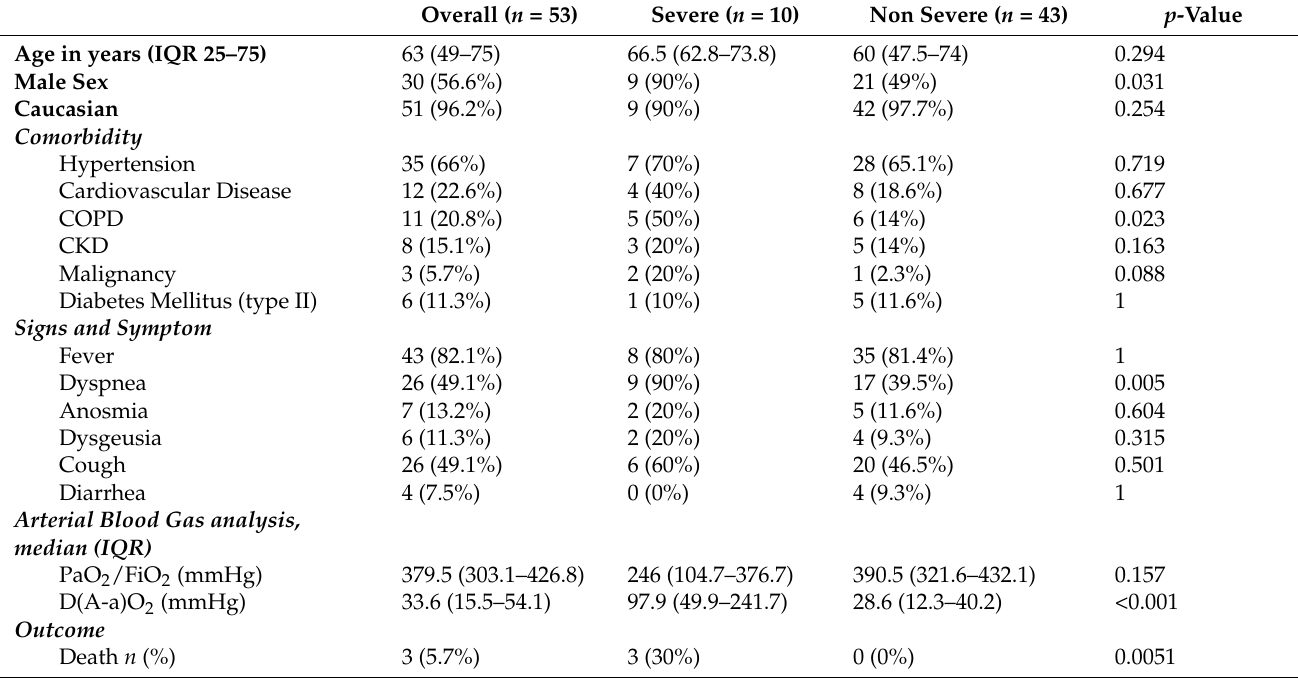
Table 2. Patients’ comorbidity, signs, and symptoms at presentation. Data are shown as median (interquartile range 25–75%), or number (percentage). Fisher exact tests were used ( α < 0.05). COPD: chronic obstructive pulmonary disease; CKD: chronic kidney disease; Data are shown as a num- ber (percentage), or median and interquartile range (IQR) 25–75%. PaO 2 /FiO 2 : arterial oxygen partial pressure (PaO 2 ) to fractional inspired oxygen (FiO 2 ) ratio. D(A-a)O 2 : alveolar–arteriolar oxygen gradient.